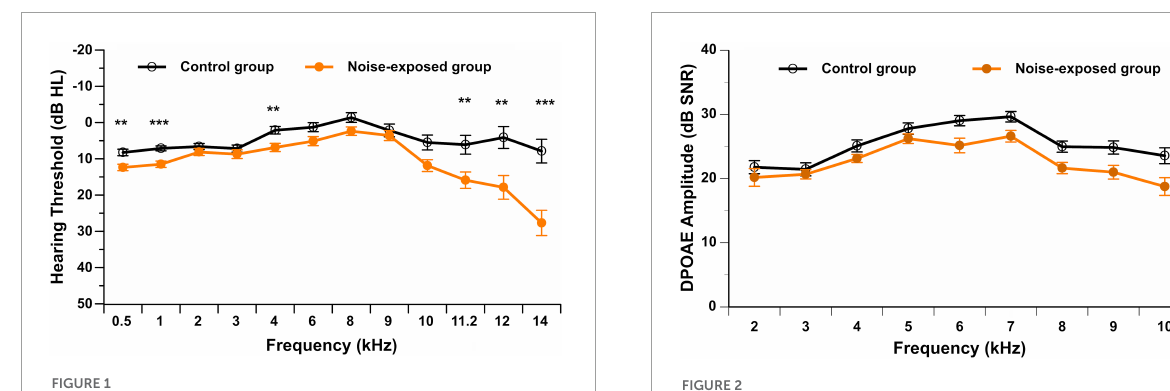
FIGURE1 Pure-tone audiometric thresholds (in dB HL) in the better ear from 0.5 to 14 kHz in noise-exposed and control group participants. Error bars represent the standard error. ** p < 0.01; *** p < 0.001.